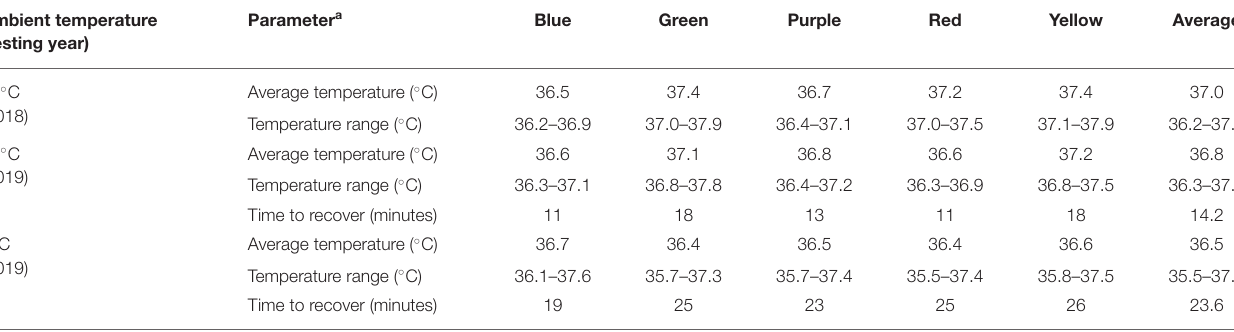
TABLE 1 | Consistency of internal temperature profiles and recovery times after opening the incubator lid and disassembling the outer and inner chambers for 1min. Ambient temperature Parameter a Blue Green Purple Red (testing year)